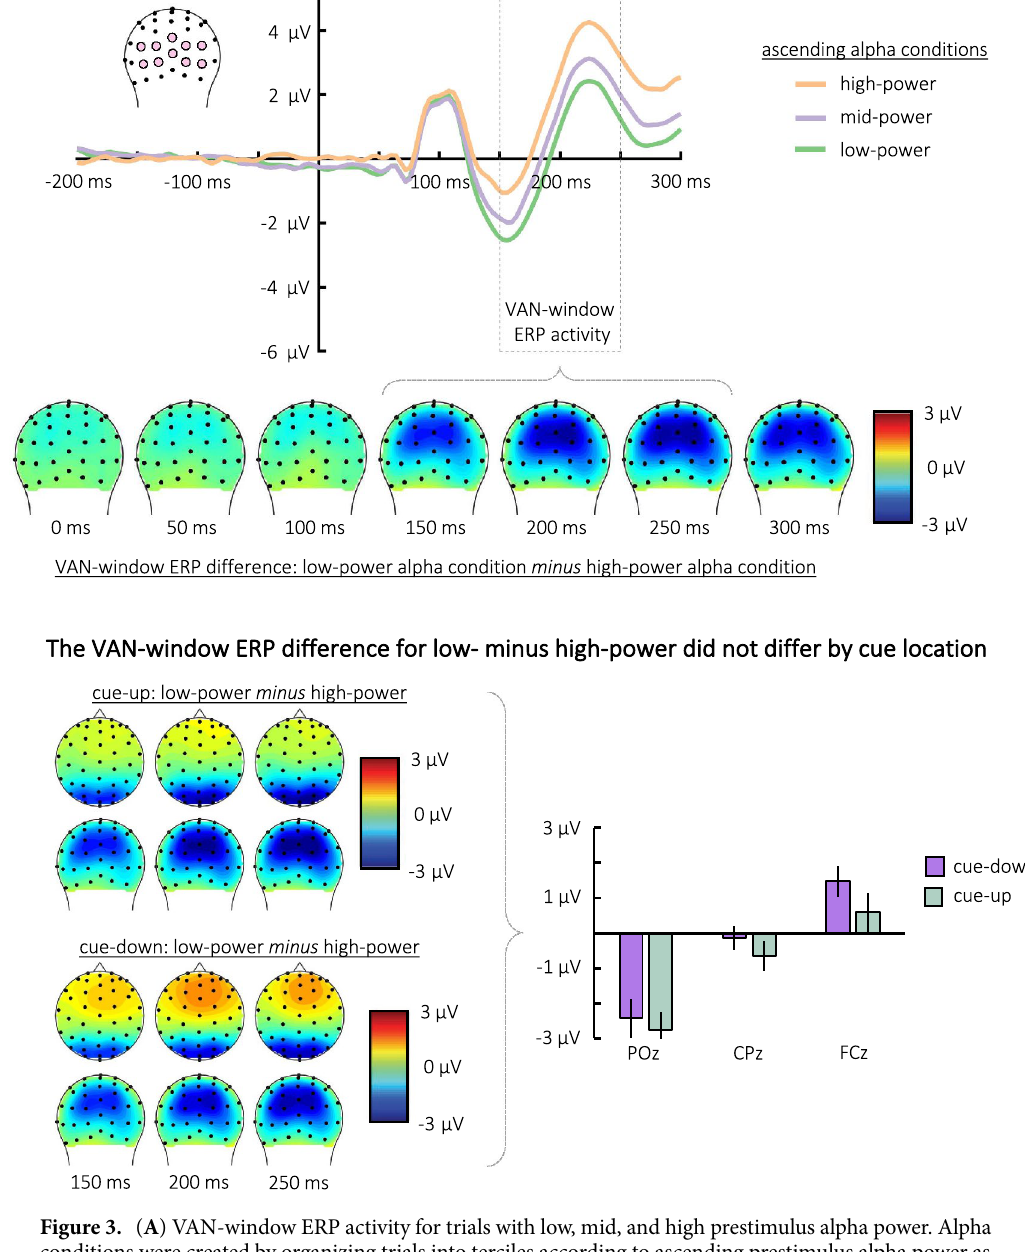
Figure 3. ( A ) VAN-window ERP activity for trials with low, mid, and high prestimulus alpha power. Alpha conditions were created by organizing trials into terciles according to ascending prestimulus alpha power as averaged within a specific spatiotemporal ROI. Cue-locked ERP raw traces for each prestimulus alpha condition are plotted (top panel) along with the topographic distribution for the difference wave derived from the low minus high alpha conditions (bottom panel). A Bayesian mixed-effect regression showed strong evidence that VAN-window ERP amplitudes were more negative for the low-power versus the high-power alpha conditions. This indicates that lower prestimulus alpha was associated with more negative VAN-window ERP amplitudes. ( B ) The left-side topo plots illustrate the ‘low-power minus high-power’ VAN-window ERP difference for trials when the cue appeared in the upper visual field (cue-up) and for trials when the cue appeared in the lower visual field (cue-down). Illustrated in the right-side bar plot, a Bayesian generalized mixed-effect regression showed no difference in amplitude between the ‘cue-up’ and ‘cue-down’ trials across three medial electrode